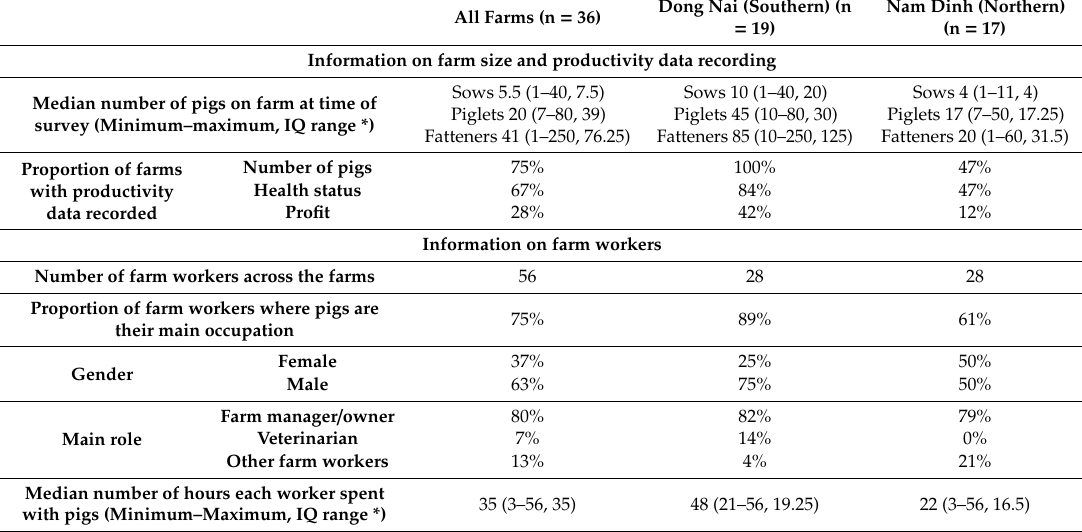
Table 1. Demographic information for the farms in the study into antimicrobial use in commercial pig production in Vietnam. Dong Nai (Southern) (n Nam Dinh (Northern) All Farms (n = 36) = 19) (n = 17) Information on farm size and productivity data